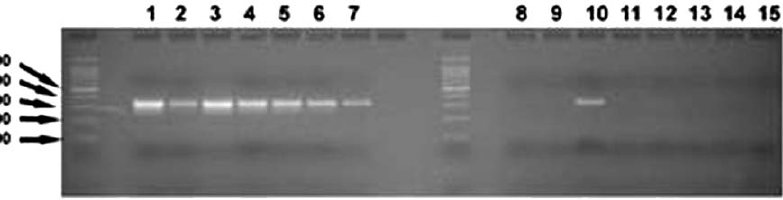
Figure 1. Specificity of the Rr- b -TUB qPCR primers under standard PCR conditions from known numbers of R.reniformis . R. reniformis DNA was isolated from vermiform J2s serving as the template. The Rr- b -TUB-primed reactions. Abbreviation, R.r. - R. reniformis . Lane 1, 1000 R.r.; Lane 2, 1000 R.r.; Lane 3, 1000 R.r.; Lane 4, 100 R.r.; Lane 5, 100 R.r.; Lane 6, 100 R.r.; Lane 7, 10 R.r.; Lane 8, 10 R.r.; Lane 9, 10 R.r.; Lane 10, 1 R.r.; Lane 11, 1 R.r.; Lane 12, 1 R.r.; Lane 13, 1 R.r.; Lane 14, No DNA; Lane 15, No primers.